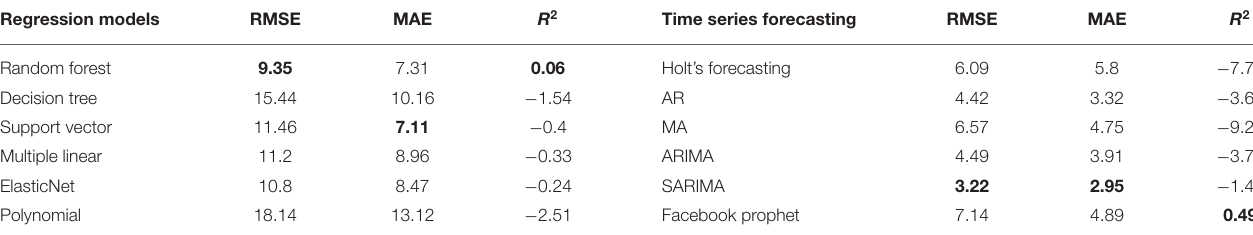
TABLE 9 | Performance metrics comparison table for Ratnagiri. Regression models